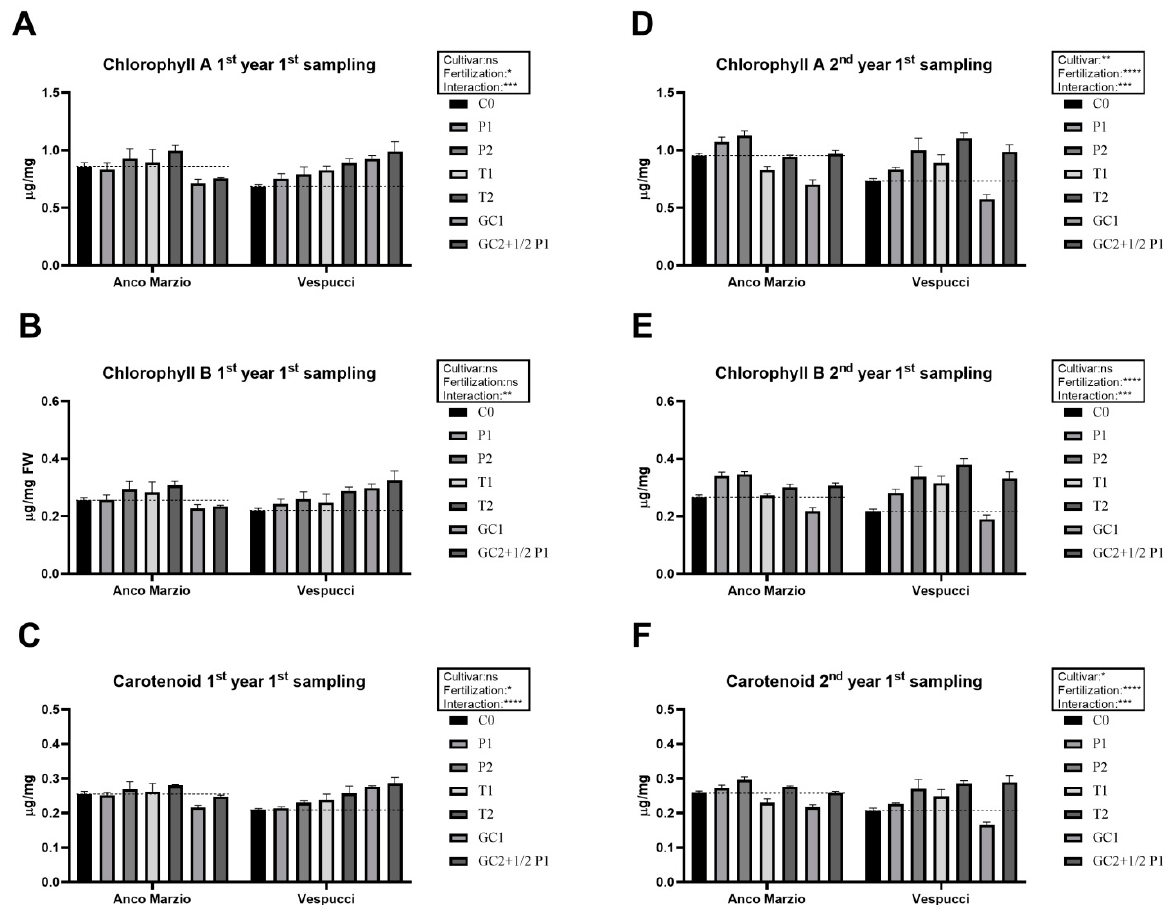
Figure 5. Pigment (Chlorophyll A, B, and Carotenoid) content on samples collected during the first crop stage (tillering). Data are related to the first ( A – C ) and second ( D – F ) year of analyses. Data were reported by indicating the statistical significance of two factors (Cultivar and Fertilization) and their interaction. Data are reported with p -values. * p ≤ 0.05; ** p ≤ 0.01; *** p ≤ 0.001; **** p ≤ 0.0001; ns: